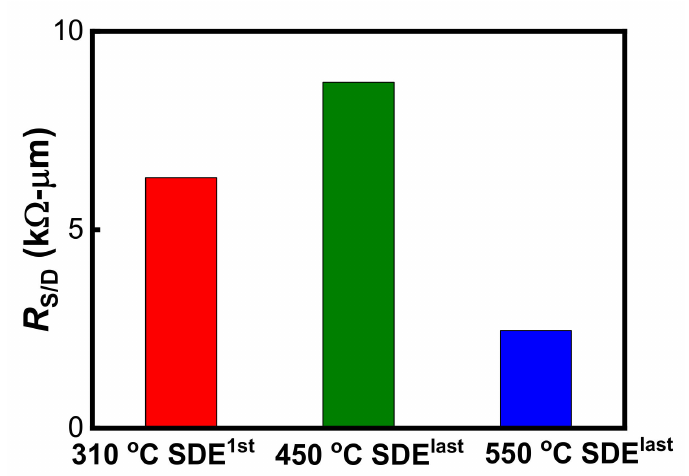
Figure 3. R S/D at V DS = − 0.1 V of the Schottky S/D pFinFETs with different SDE processes.